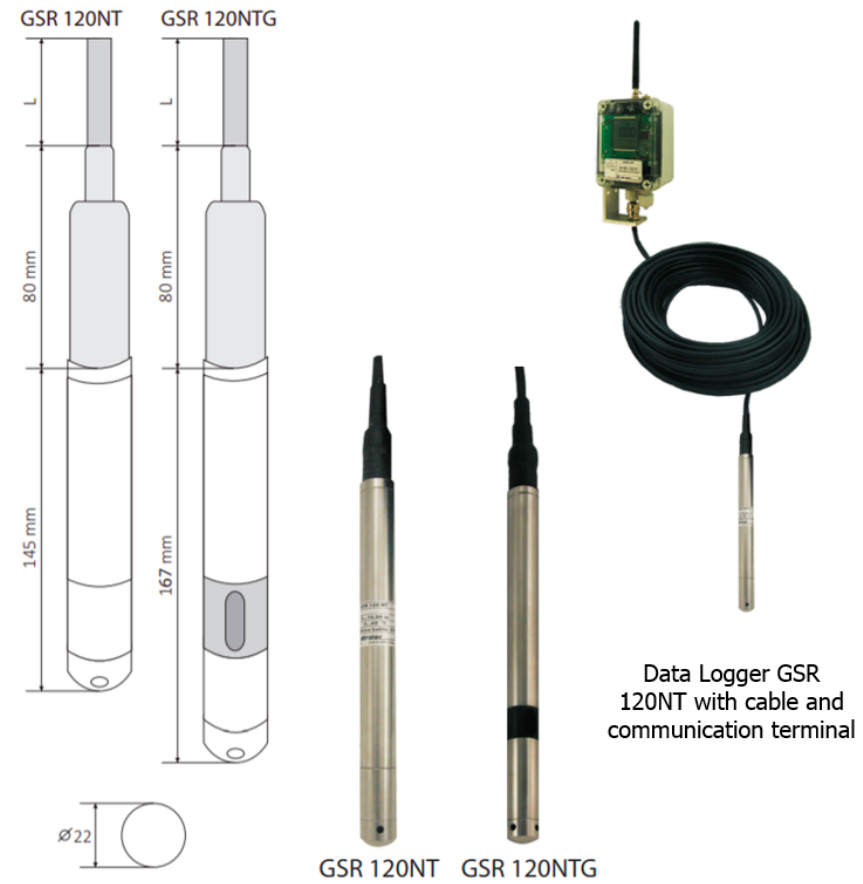
Figure 9. Sensors used in the measurement—GSR 120 NT and 120 NTG.